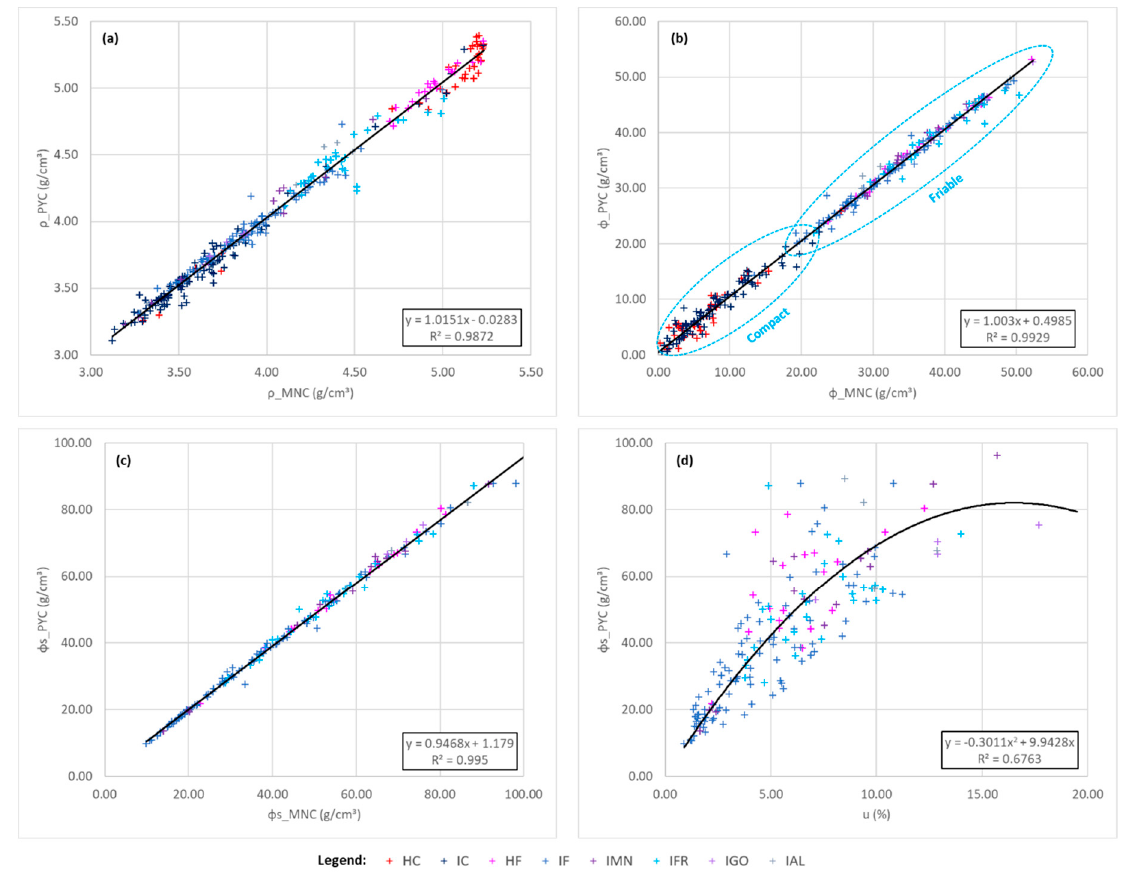
Figure 3. Scatter diagrams mineral density ( a ), porosity ( b )—data from the Table 2 (subgroups 1 and 2), and saturation ( c ) calculated by MNC (Mineral Norm Calculations) and PYC (Pycnometry) methods, and moisture and saturation of PYC method ( d )—data from the Table 3 (subgroup 2).